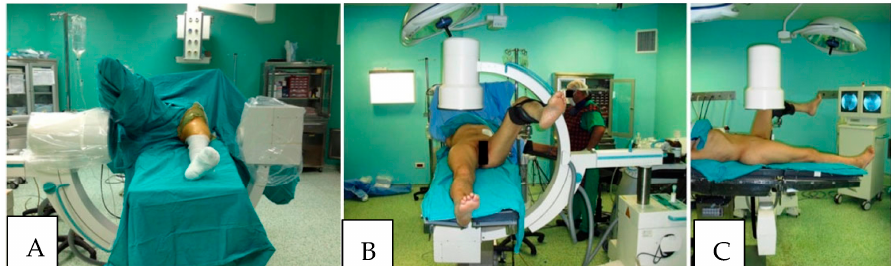
Figure 1. ( A ) Typical patient positioning in the hemi-lithotomy position for intramedullary nailing and open reduction and internal fixation of proximal femur fractures. The well-leg (L) is held flexed at the hip and knee in a generic “well-leg” holder. The operative leg is positioned with the hip and knee extended. The C-arm can be positioned ( B , C ) to allow an unobstructed image of the hip in both the AP and cross-table lateral images.